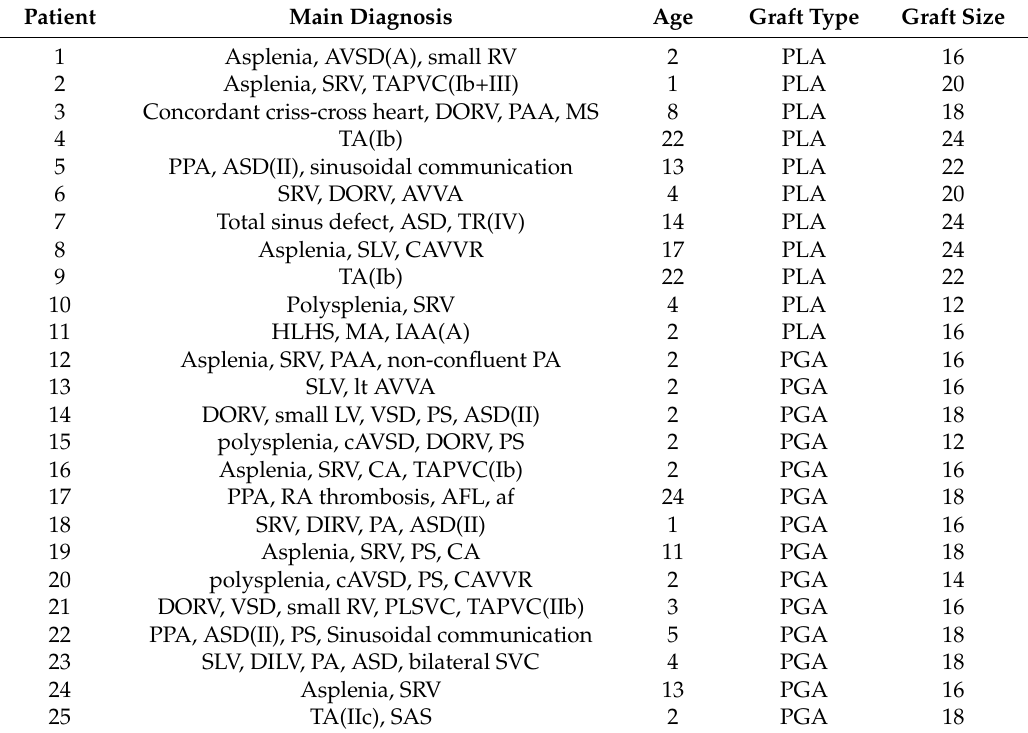
Table 1. Characteristics of the